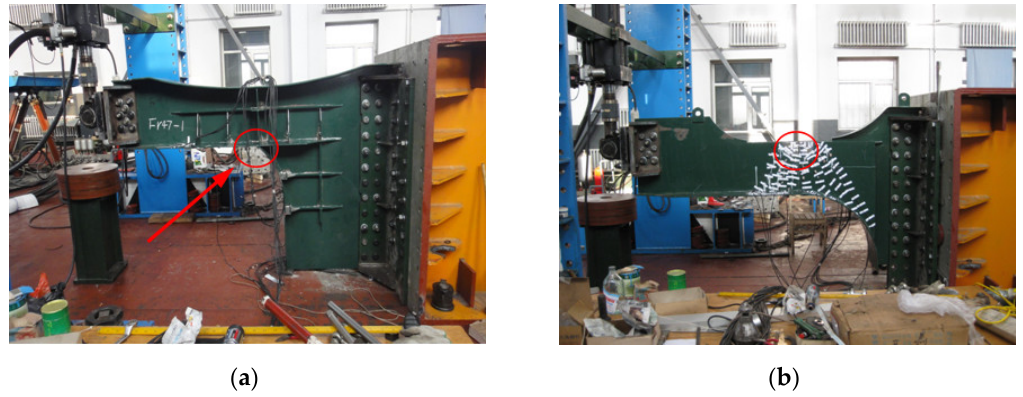
Figure 6. The photograph of the trimaran’s model test. ( a ) Model 1 and ( b ) Model 2.